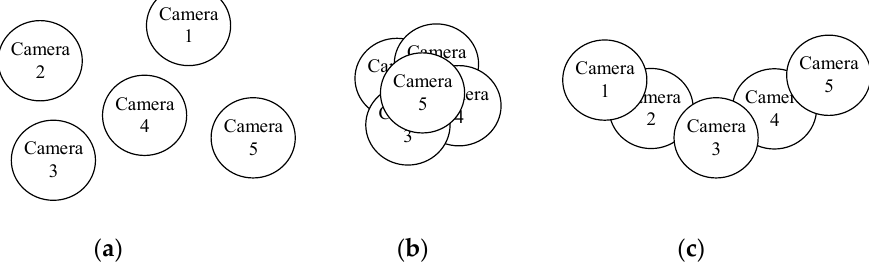
Figure 1. Different topology of cameras network ( a ) no region of overlap between any cameras ( b ) each camera overlapping with each other ( c ) each camera overlapping with one or two cameras